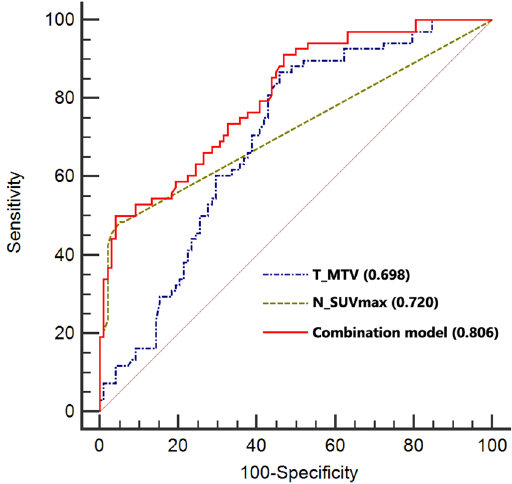
Figure 2. Graphs of ROC curve analysis show significant additional value of T_MTV for predicting regional LN metastasis in rectal cancer. Although comparison of AUC between N_SUVmax (0.720) and T_MTV (0.698) was not significant ( P = 0.64), c-statistics when T_MTV was added to N_SUVmax (0.806) showed significant improvement in accuracy of risk prediction for LN metastasis (0.806 for c-statistics of combination model vs. 0.698 for T_MTV; P = 0.0002, 0.806 for c-statistics of combination model vs. 0.720 for N_SUVmax; P =